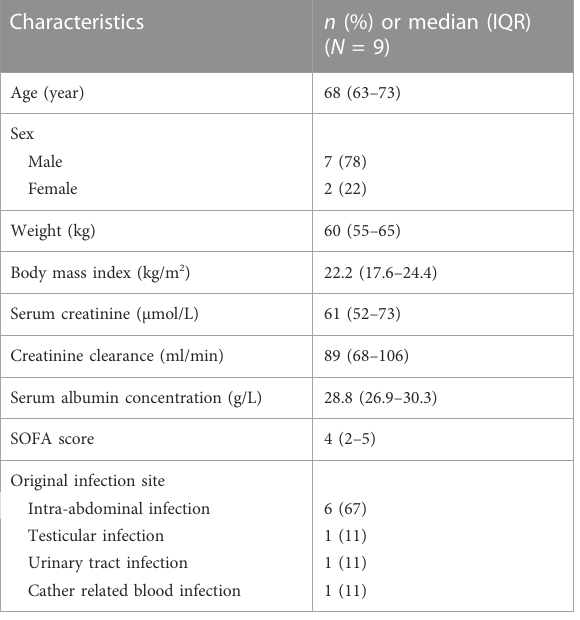
TABLE 2 Baseline characteristics of enrolled patients. Characteristics